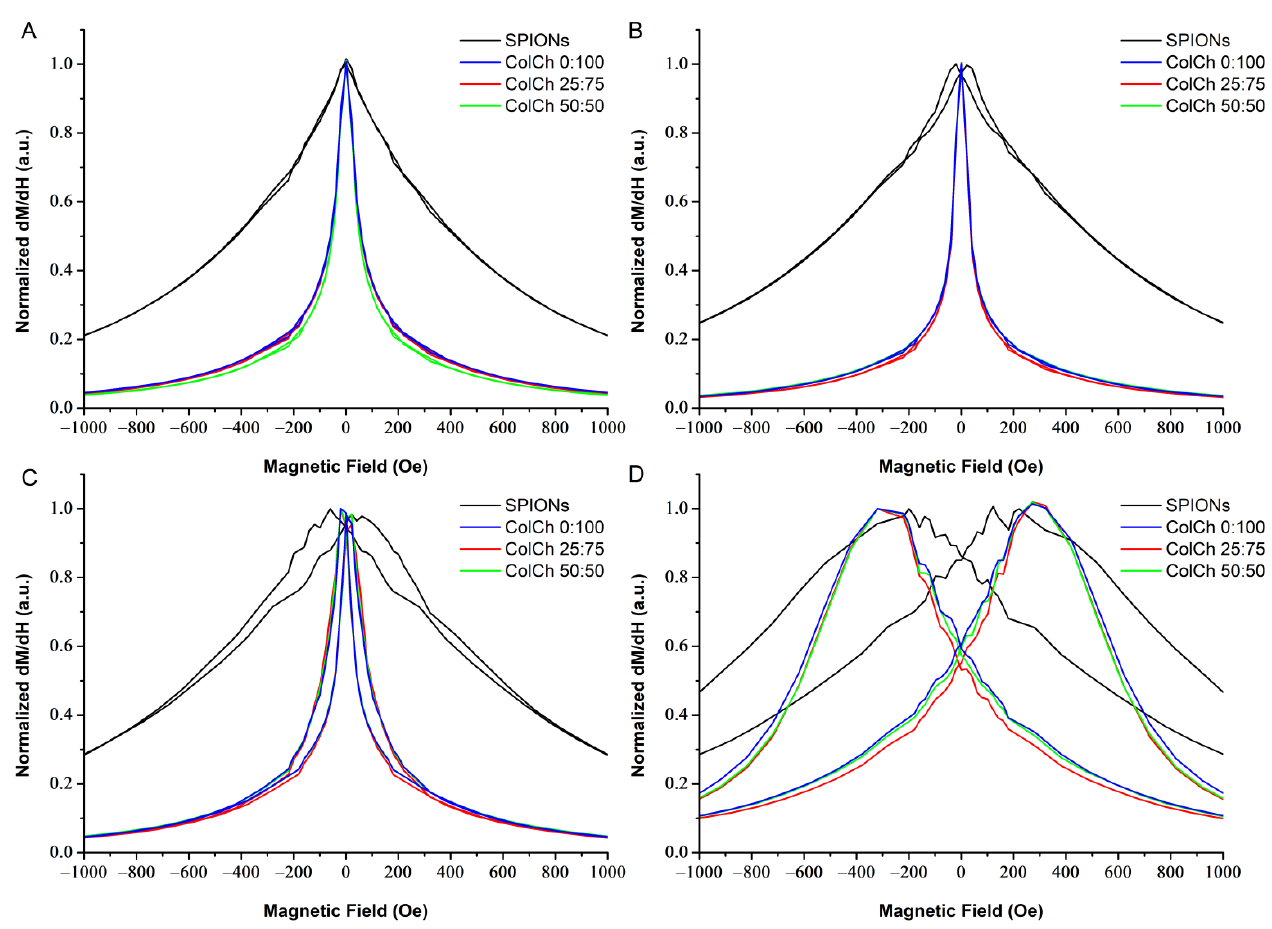
Figure 4. Normalized derivative of magnetization (normalized differential susceptibility) in function of the magnetic field at different temperatures: 300 K ( A ), 200 K ( B ), 100 K ( C ), and 4 K ( D ) for SPIONs and hybrid materials.